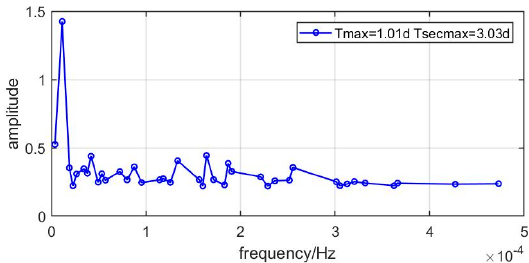
Figure 8. Spectrum analysis results of RDSS timing error.